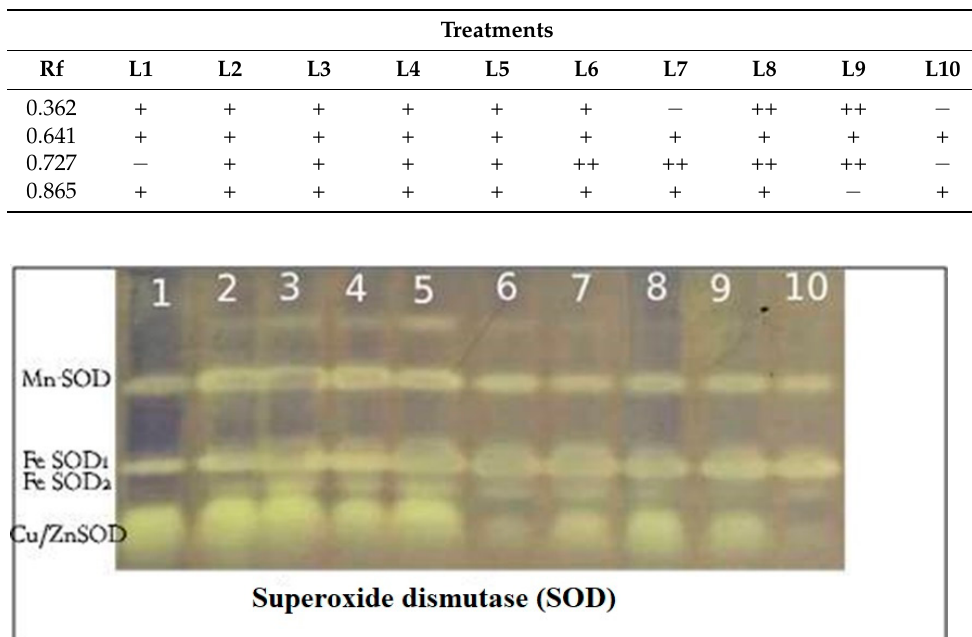
Table 5. Isomers of superoxide dismutase enzymes (+/ − ) and their Retention factor (Rf) in response to salinity stress, foliar application of chitosan dissolved in different organic acids (Ch ACE, Ch ASC, Ch CIT and Ch MAL) and their interactions on tomato plants. L1 = Control, L2 = Ch ACE, L3 = Ch ASC, L4 = Ch CIT, L5 = Ch MAL, L6 = S, L7 = S + Ch ACE, L8 = S + Ch ASC, L9 = S + Ch CIT and L10 = S + Ch MAL.